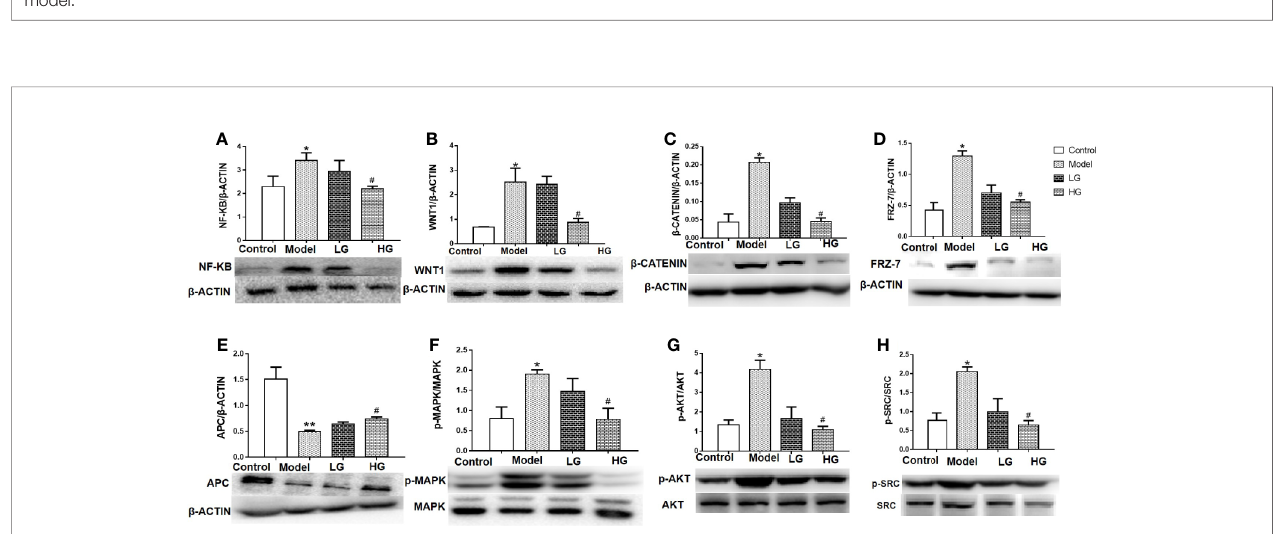
FIGURE 6 | Expression of NF-kB p65, WNT1, b -catenin, Frz-7, APC, p-mapk/mapk, p-Akt/Akt, and p-src/src in the liver of mice with DEN-induced liver cancer. (A) Expression of NF-kB p65 in liver tissue. (B) Expression of WNT1 in liver tissue. (C) Expression of b -catenin in liver tissue. (D) Expression of Frz-7 in liver tissue. (E) Expression of APC in liver tissue. (F) Expression of p-MAPK/MAPK in liver tissue. (G) Expression of P-AKt/AKt in liver tissue. (H) Expression of p-src/src in liver tissue. NF-kB p65, WNT1, b -catenin, Frz-7, APC, p-mapk/mapk, p-Akt/Akt and p-src/src data in the liver cancer microenvironment were analyzed by ANOVA. The homogeneity test was fi rst performed, P > 0.05, the variances were uniform, and the LSD (L) test was used for multiple comparisons afterward, P < 0.05, the variances were not uniform. *p < 0.05, **p < 0.01 vs. control; # p < 0.05 vs. model. Data were analyzed using single-variance t -test.